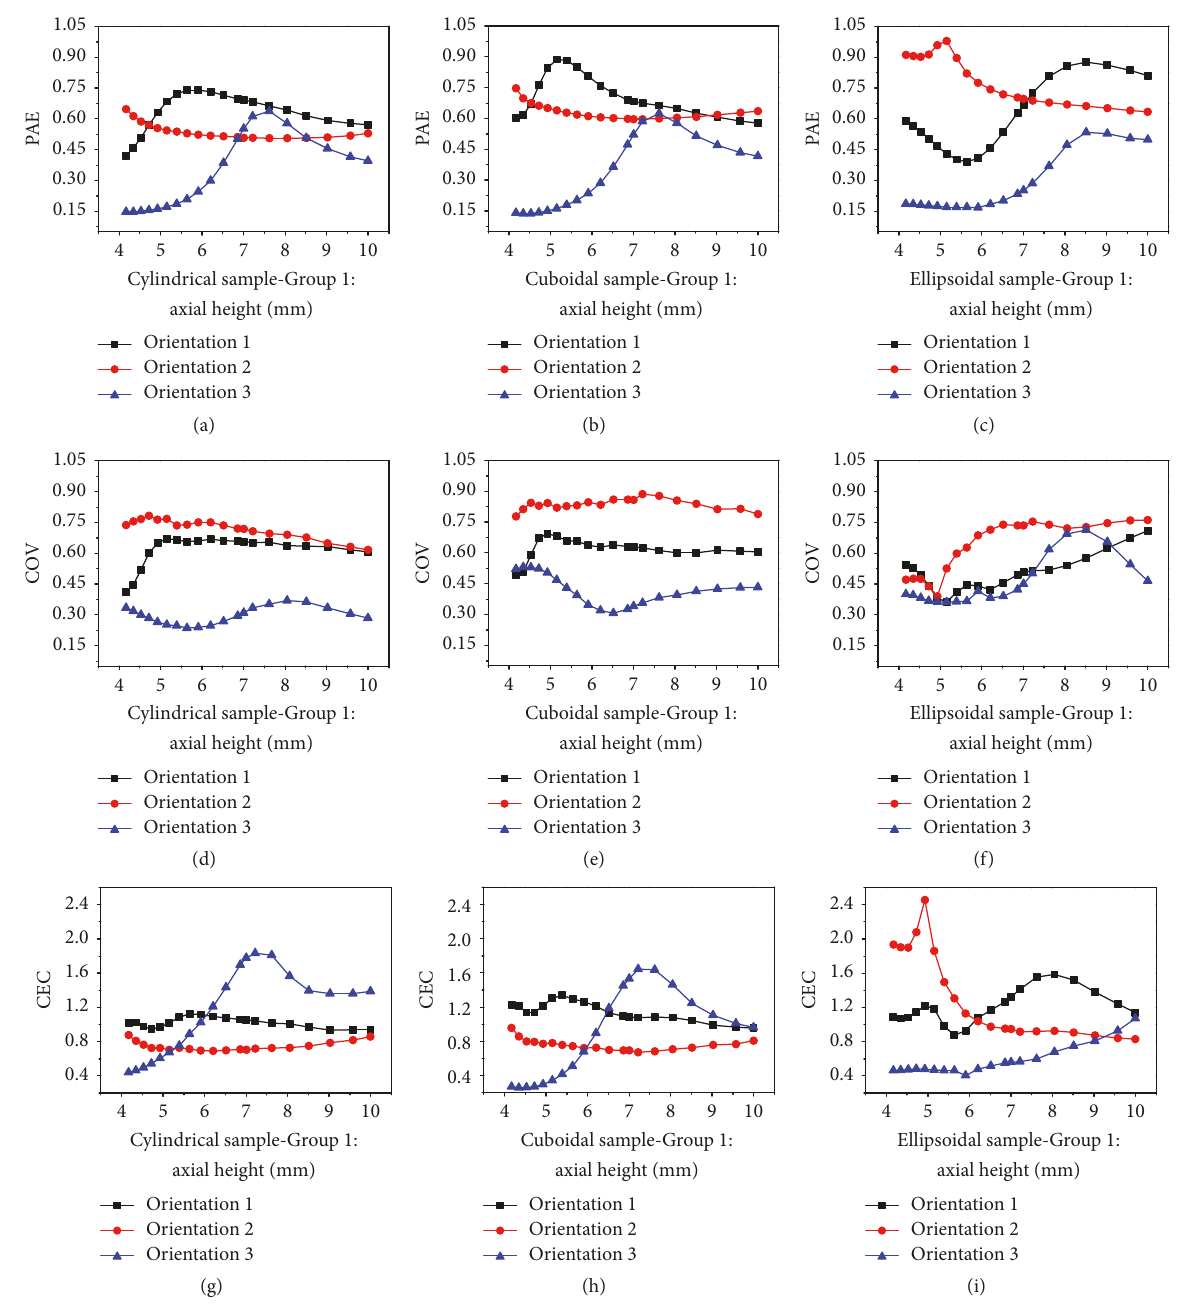
Figure 26: Same samples in different orientations, Group